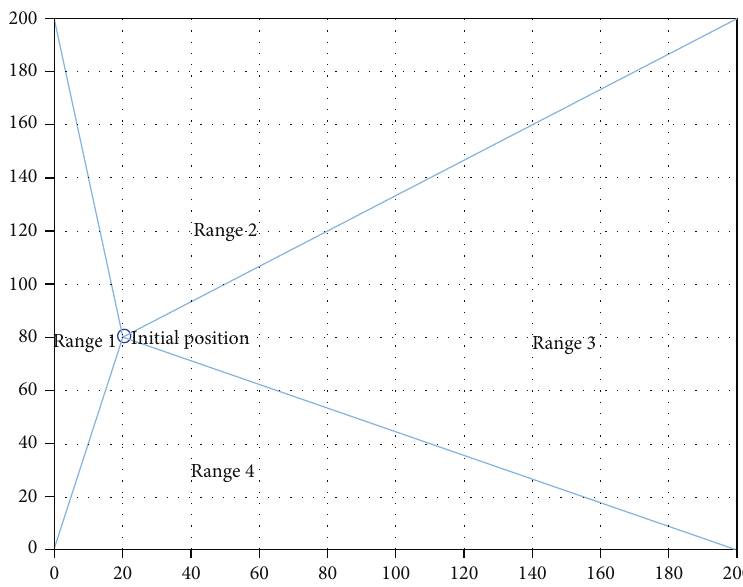
Figure 3: Example regions divided by UAV